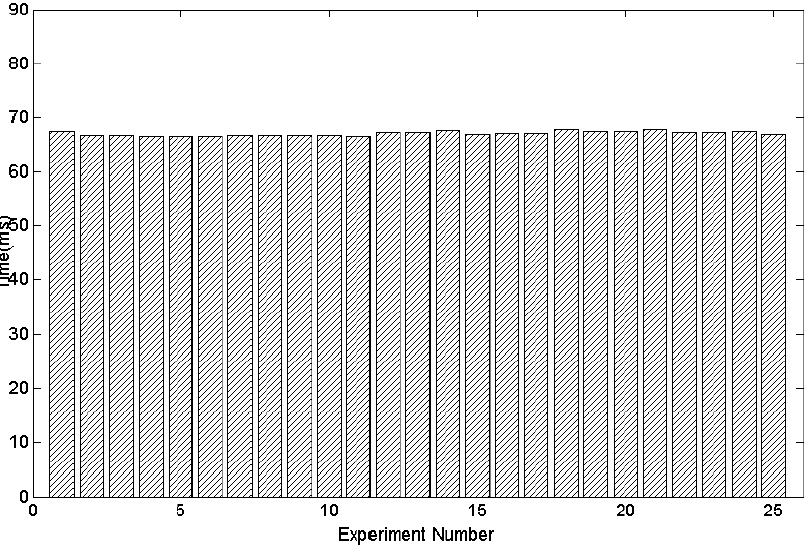
Figure 18. The time cost of 25 times by 5 users for an experimental Figure 17. The time cost of 25 times by 5 users for an experimental task.